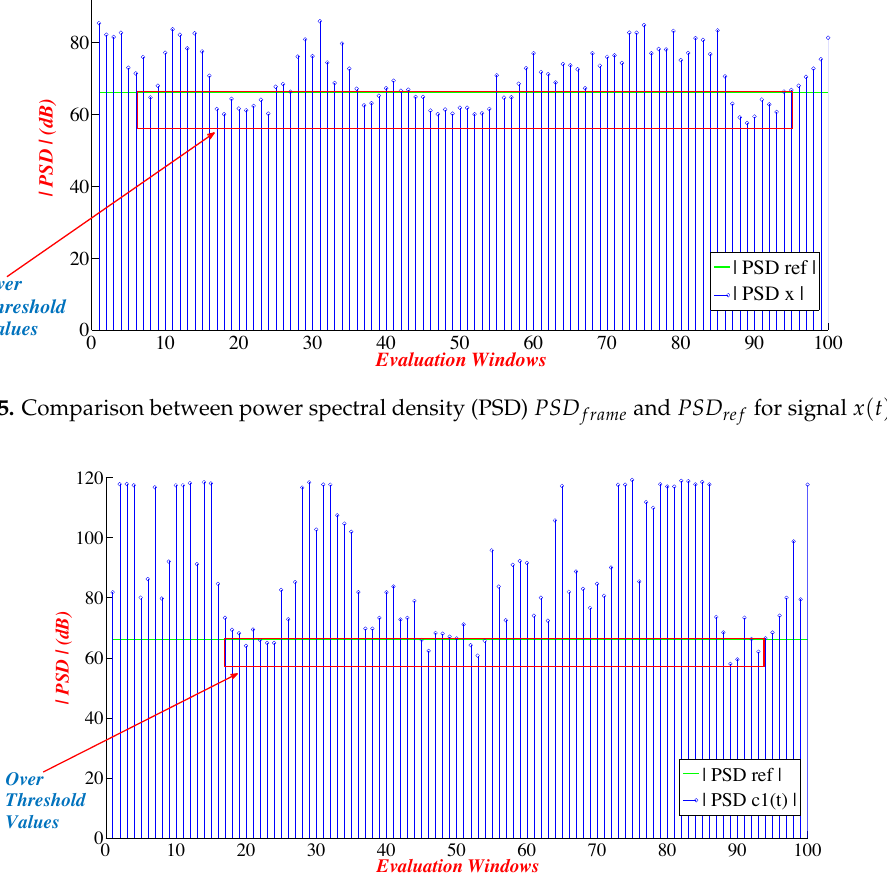
Figure 6. Comparison between PSD frame and PSD ref for signal c 1 ( t ) .